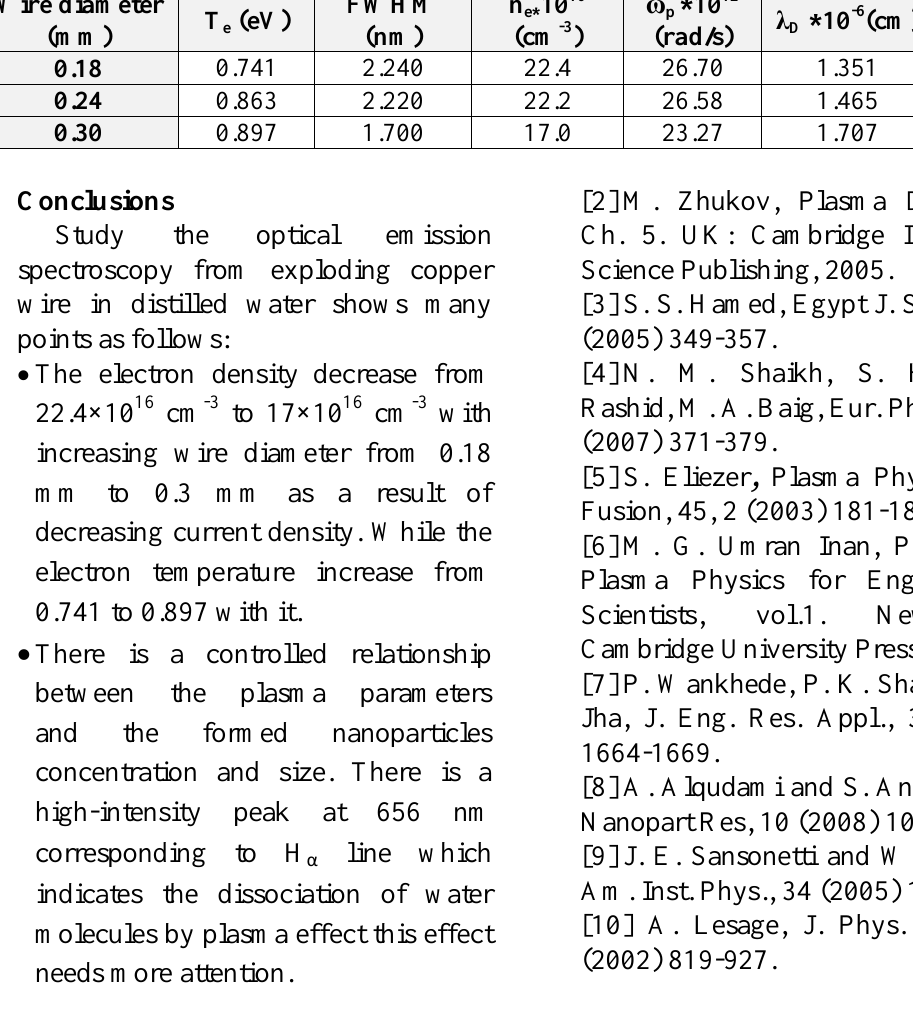
Table 1: Plasma parameters calculated from emission spectrum lines emitted from copper plasma produced by exploding wire with different wires diameters and produced nanoparticle per one pulse. Wire